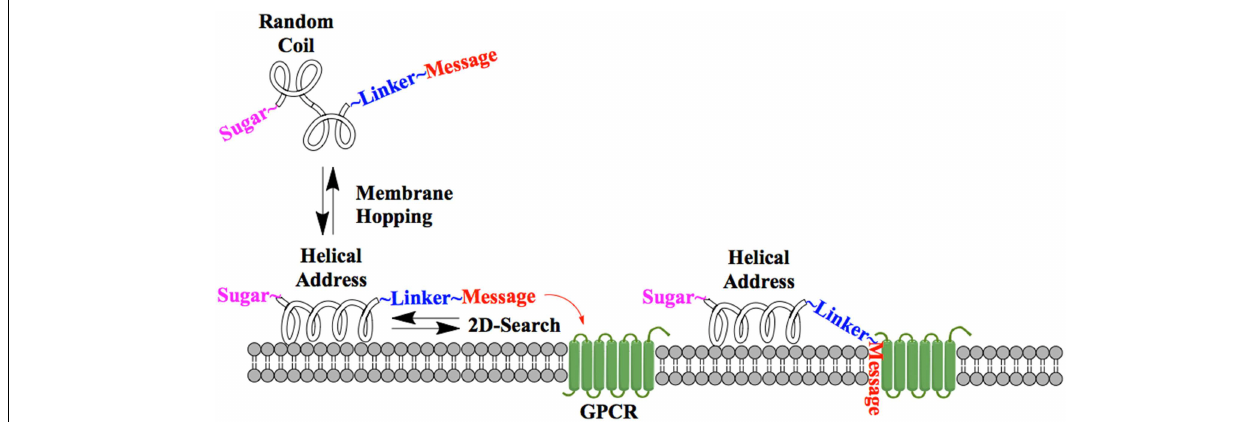
FIGURE 2 | Peptide-membrane interaction. In the presence of a membrane, a glycopeptide adopts a helical conformation and undergoes a two-dimensional “search” of the membrane exterior. If the message segment interacts with a matched receptor, binding and activation occurs.